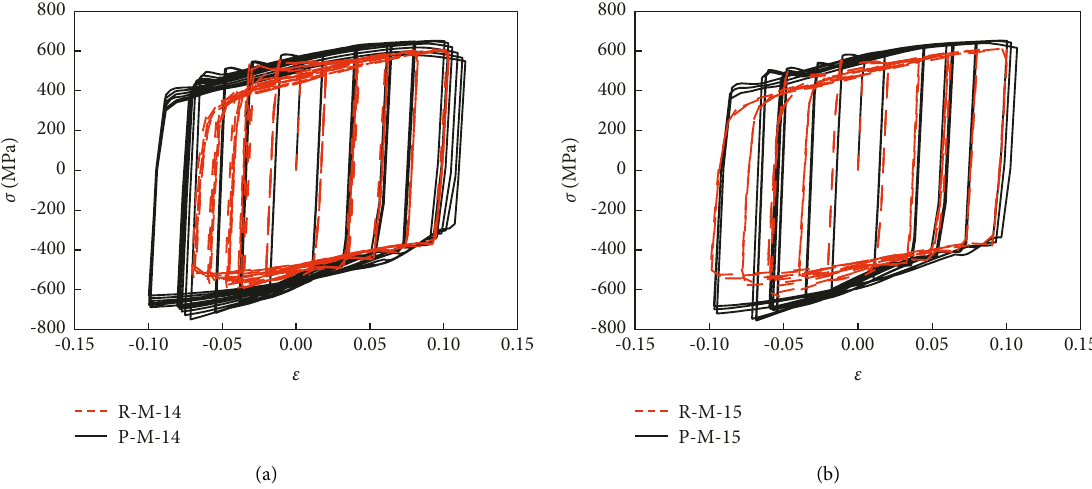
Figure 18: Hysteresis curves of material specimens with different cross section shapes. (a) Hysteresis curves of specimens under the loading pattern NM20. (c) Hysteresis curves of specimens under the loading pattern NM21.